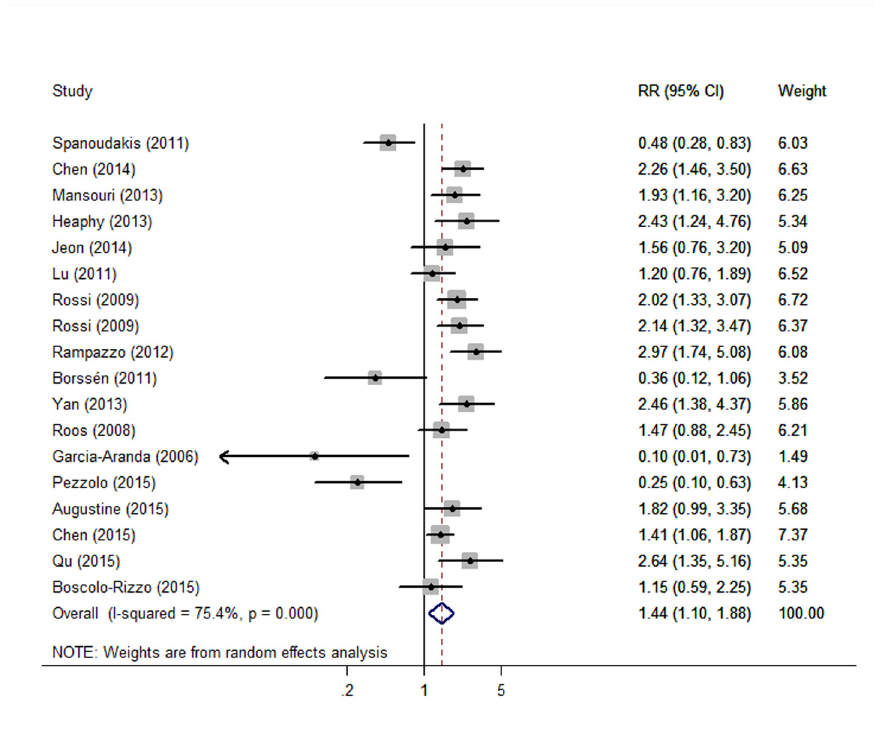
Fig 3. Forest plot for association between telomere length and cancer progression. Disease-free survival, treatment-free survival, progression-free survival and relapse-free survival were involved. Results are presented for random effects models.